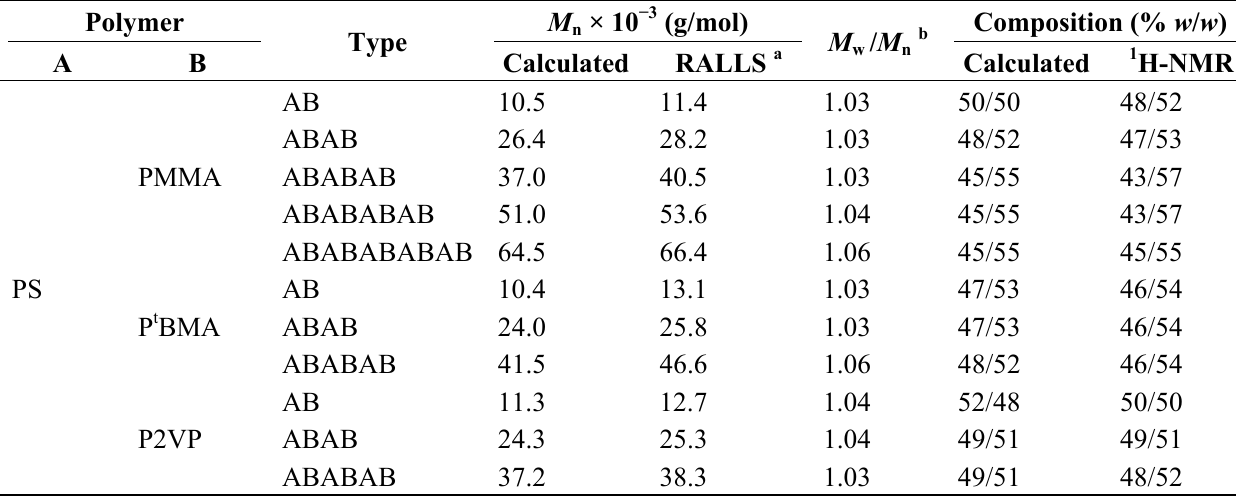
multiblock copolymers composed n